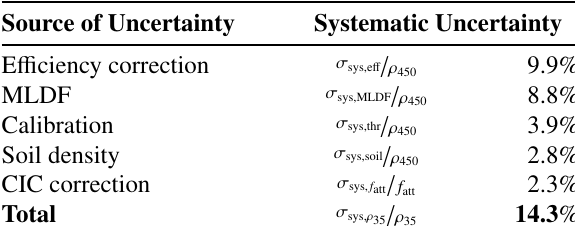
Table 1: Contributions of systematic uncertainties Source of Uncertainty